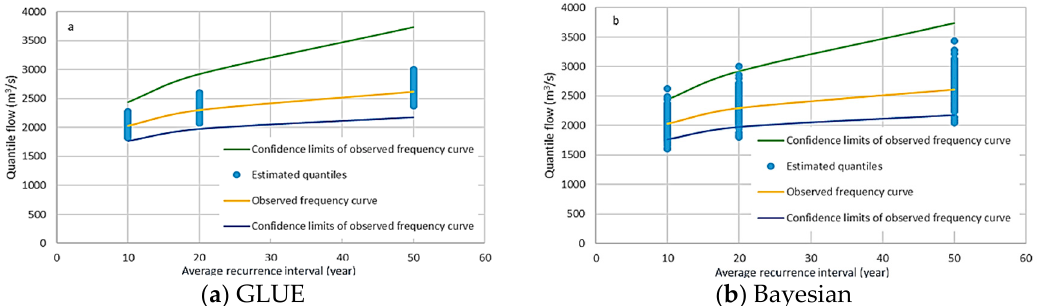
Figure 6. Uncertainty of design flood quantiles estimated using the GLUE ( a ) and Bayesian ( b ) methods.